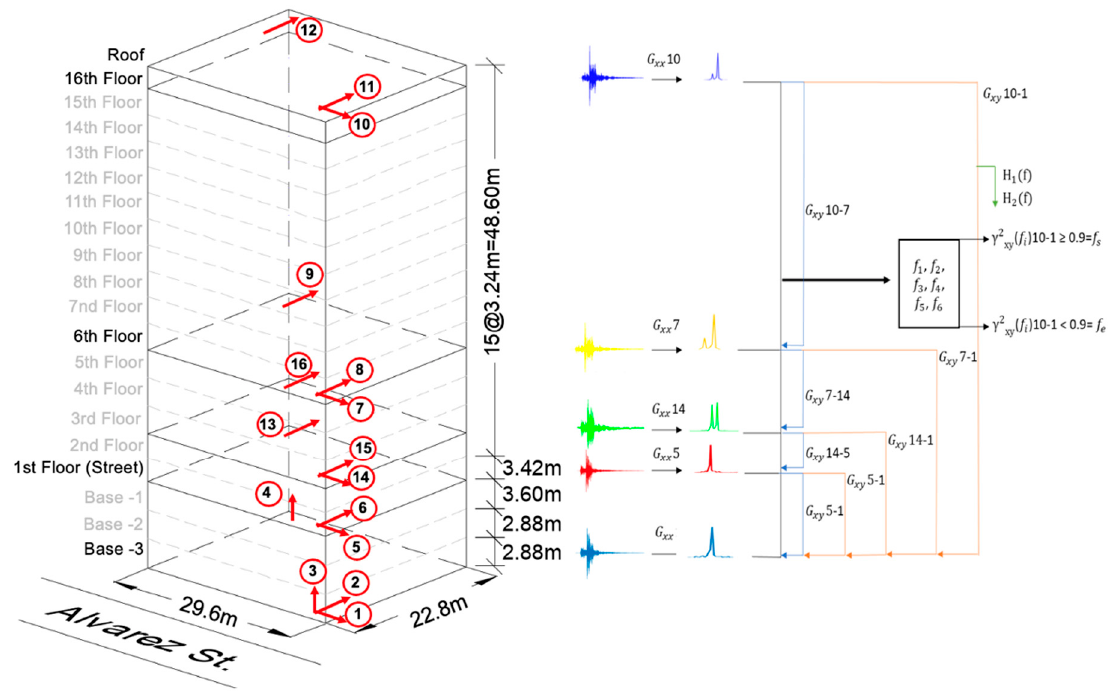
Figure 8. Graphical scheme of the nonparametric process.